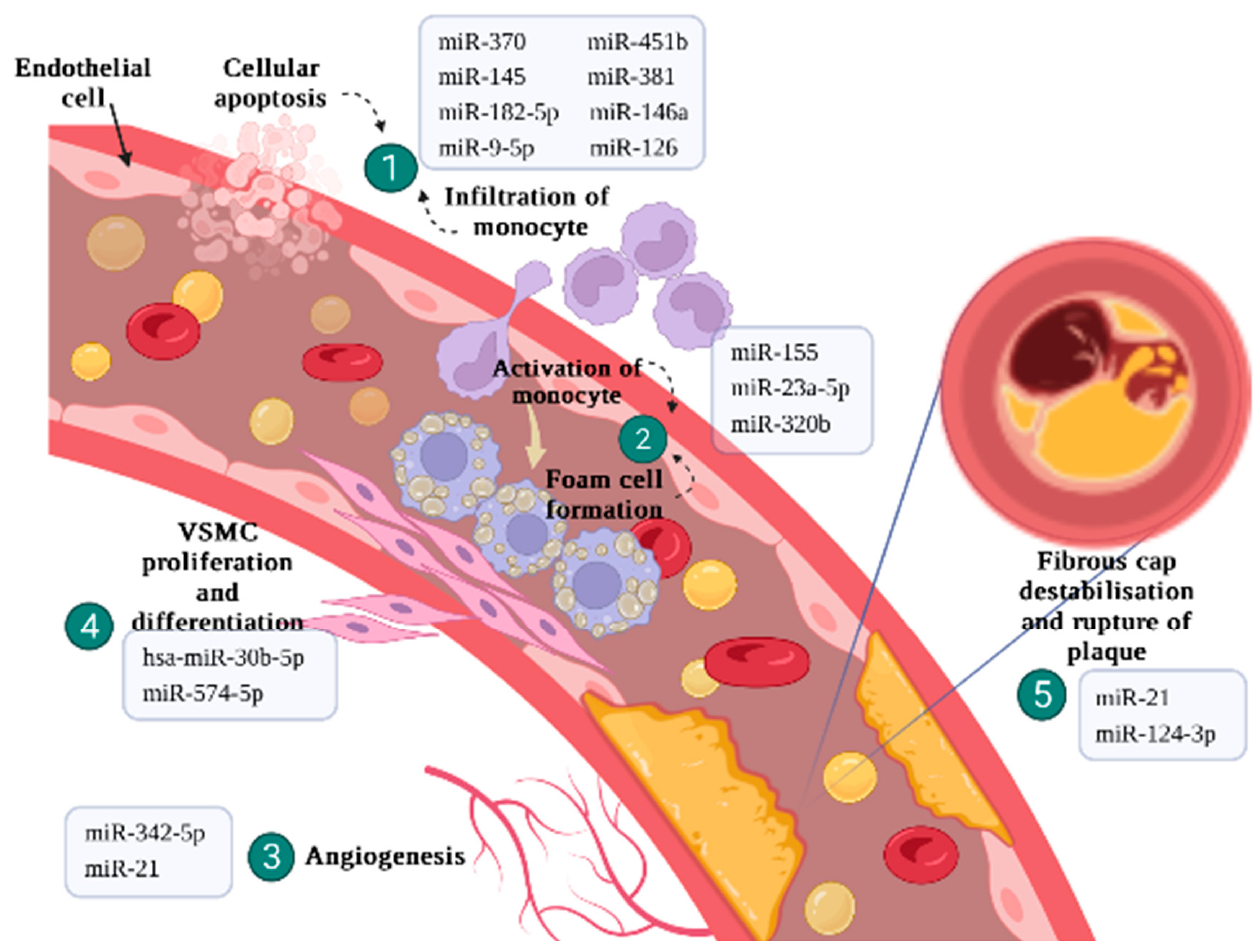
Figure 2. Involvement of miRNAs in the different steps of atherosclerosis. Plaque formation begins with endothelial dysfunction, where the regulating of endothelial cells is imbalanced and initiates the infiltration of leukocytes and monocytes into coronary blood vessels [27]. Upon activation, macrophages will transform into foam cells and trigger plaque angiogenesis to compensate for the ischemic condition. The VSMCs will continue to migrate and proliferate, subsequently, fibrous cap destabilisation and rupture of plaque, leading to the final stage of thrombosis contributing to acute coronary syndrome (ACS) [28].